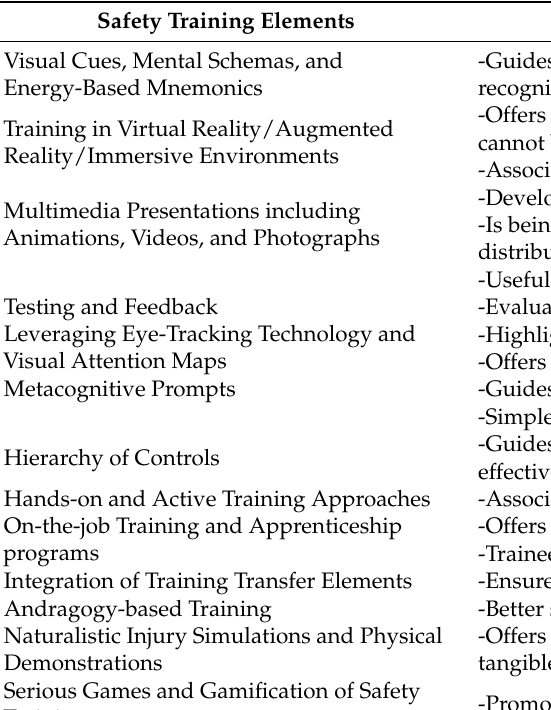
Table 1. Summary of safety training elements along with key